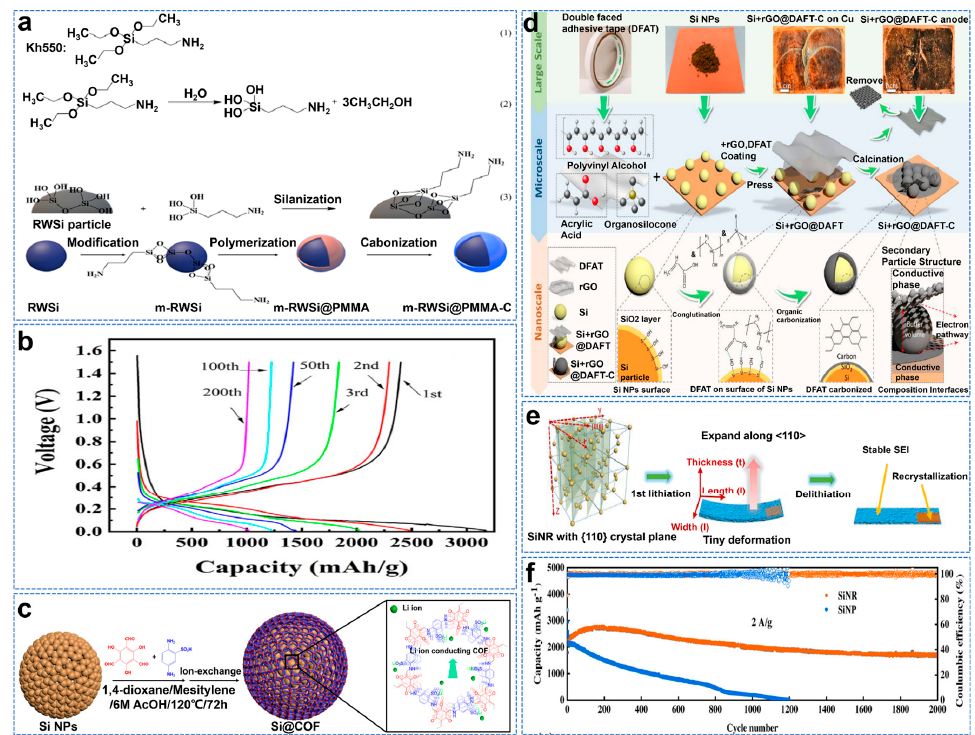
Figure 9. ( a ) Structure (1), hydrolysis reaction of kh550 (2) and schematic illustration of functionalized RWSi (3) and flow diagram of synthesis process for the m − RWSi@PMMAC composite, ( b ) Voltage profiles for different cycles at 0.2 A g − 1 [87]. ( c ) Schematic illustration of preparation of Si@COF NPs [89]. ( d ) Schematic illustration of the process for Si+rGO@DFAT − C synthesis by a facile operation, depicting the process at scales of diverse lengths [91]. ( e ) Schematic diagram of ordinary Si anode material during the first lithiation/de − lithiation process, ( f ) Specific capacity of SiNP and SiNR at 2 A g − 1 for 2000 cycles [93].